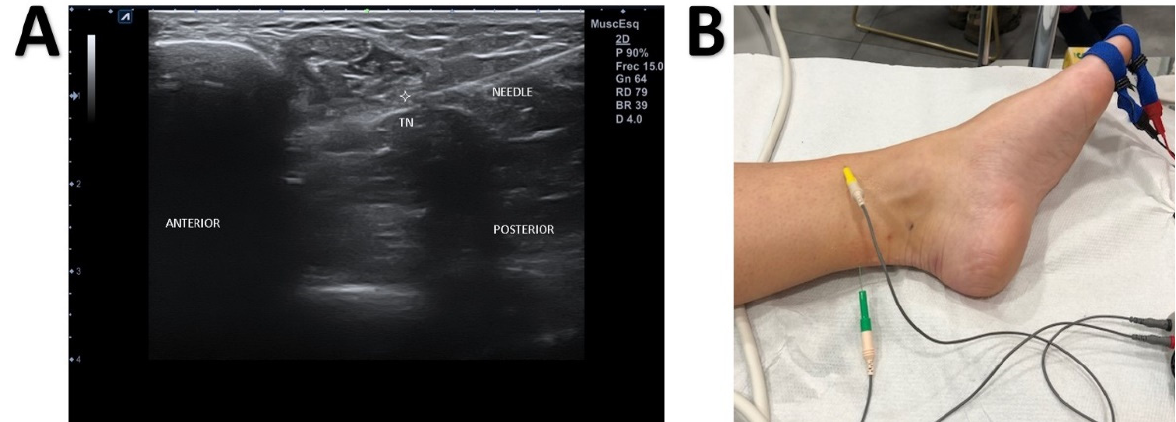
Figure 2. Ultrasound-Guided Near-Nerve Needle Sensory (USG-NNNS) Technique. ( A ) Ultrasound image showing the position of the needle relative to the tibial nerve (TN). ( B ) Placement of the active recording needle (green) and reference electrodes (yellow) for the near-nerve needle sensory (NNNS) technique.